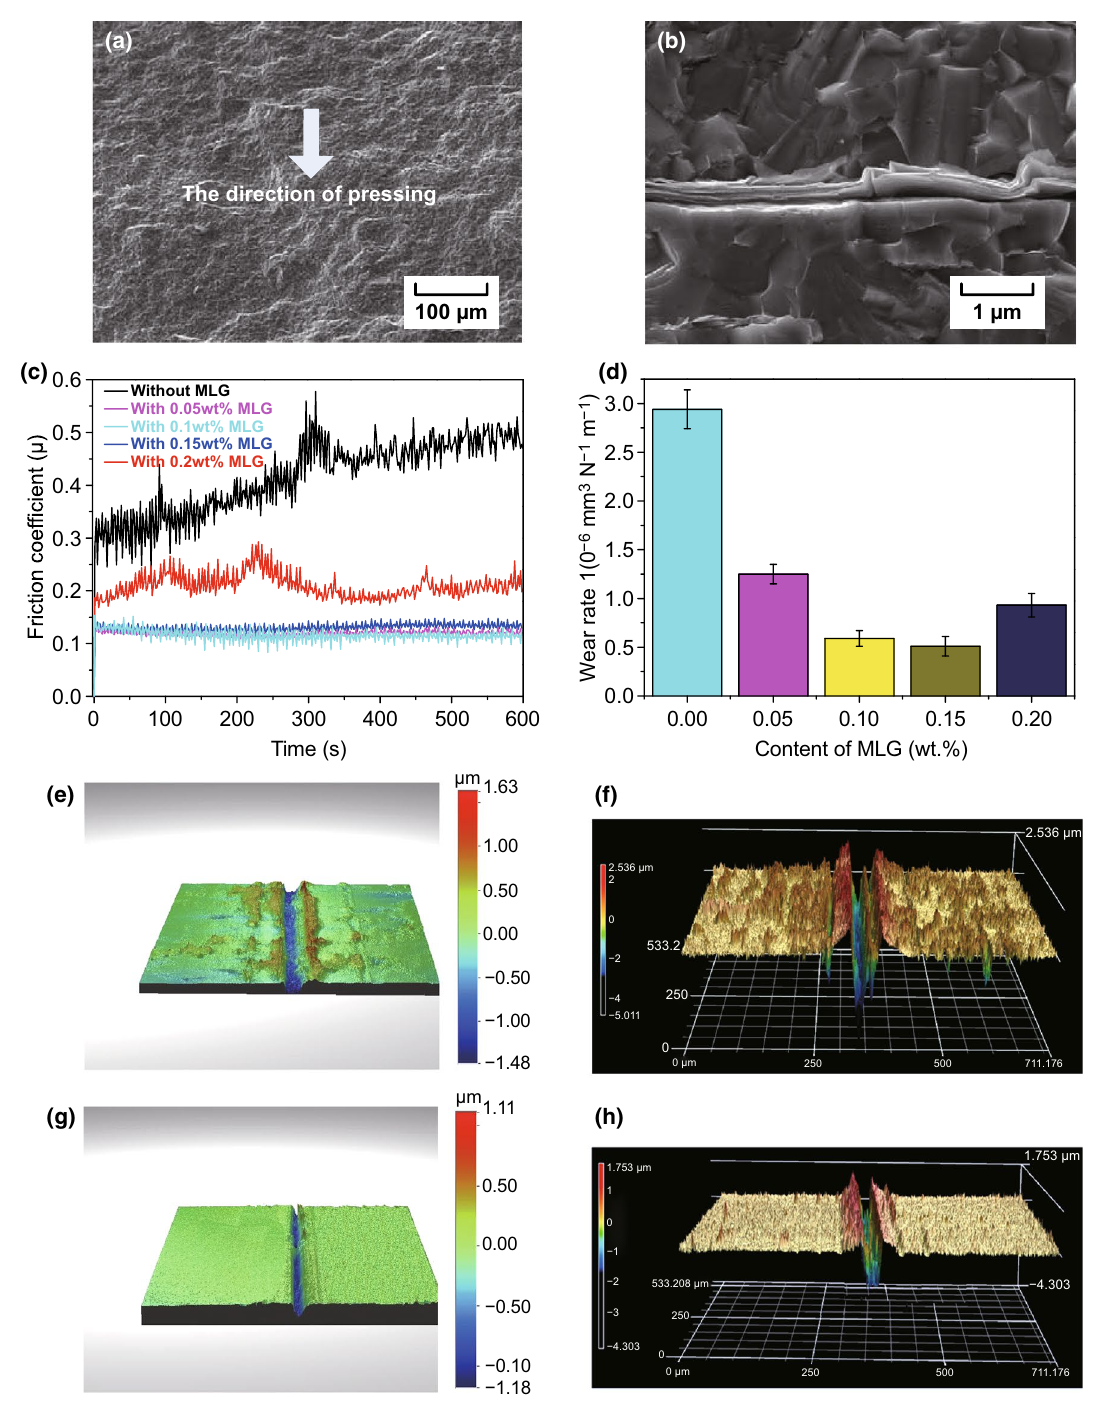
Fig. 19 Preferential orientation of MLG in WC ceramics after hot‑pressing a in low magnification and b in high magnification, influence of MLG contents on c friction coefficient and d wear rates, surface topographies of wear tracks on e , f monolithic WC ceramics and g , h ceramics containing 0.1 wt% MLG [178]. Figure panels reproduced from Ref. [178] with permission from Elsevier copyright